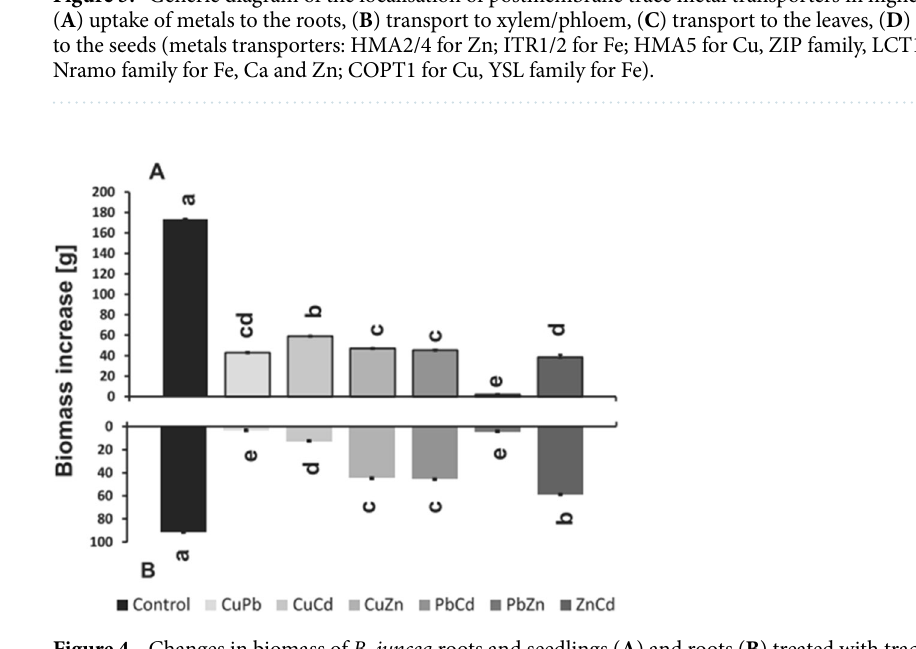
Figure 4. Changes in biomass of B. juncea roots and seedlings ( A ) and roots ( B ) treated with trace metals: CuPb, CuCd, CuZn, PbCd, PbZn, and ZnCd after 96 h of cultivation. The results are expressed as the mean ± standard deviation (n = 3), with results of Duncan’s Test, made separately for A and B. Metal solutions Pb(NO 3 ) 2 , CuSO 4 , CdCl 2 , and ZnSO 4 were applied at 25 μM concentration of